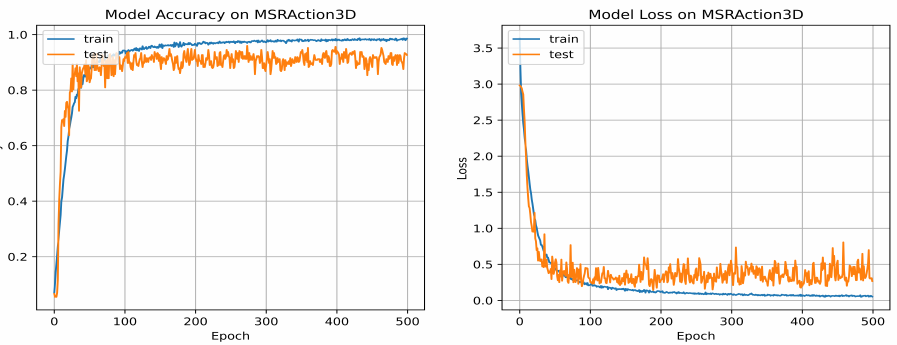
Figure 6. Accuracy and loss of our system for MSRAction3D dataset using AdaMax optimizer of 0.001 learning rate on 500 epochs.